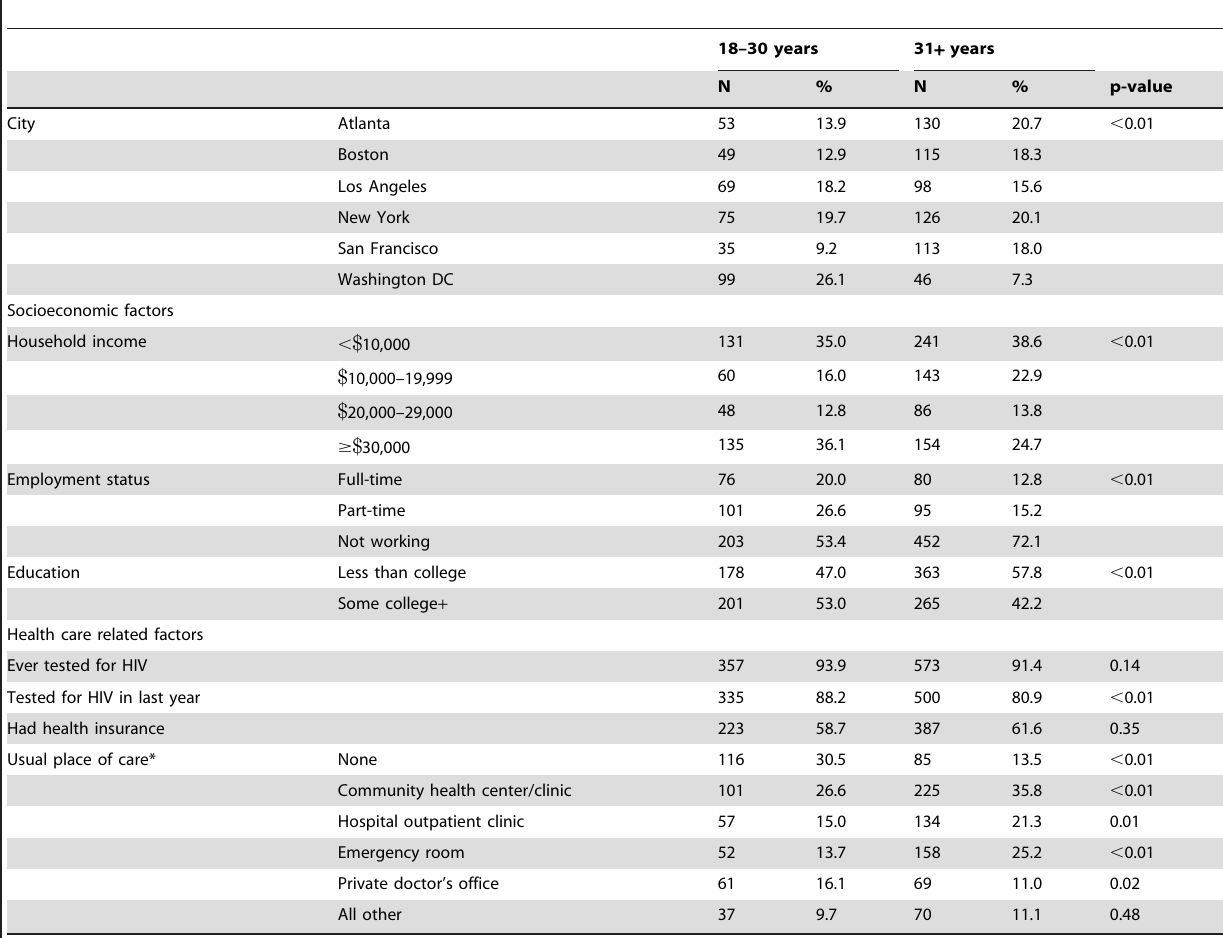
Table 3. Baseline characteristics by age group, HPTN